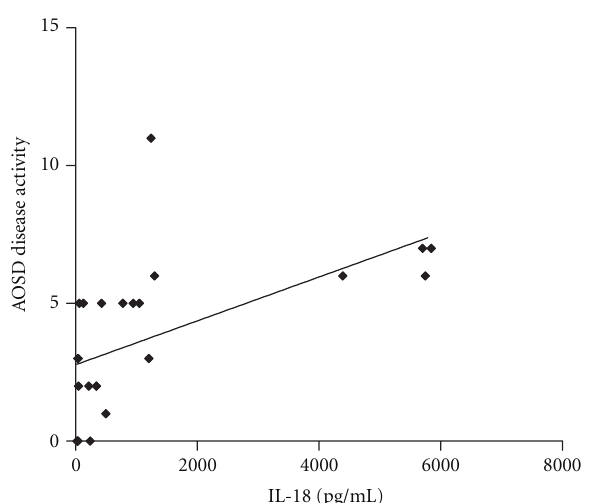
Figure 4: Correlation between disease activity and IL-18 serum